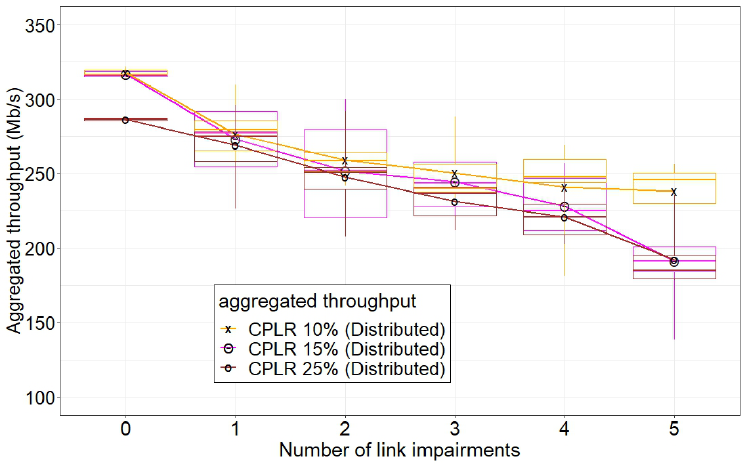
Figure 12. Aggregated throughput behavior of distributed network operation, during data plane link failures for various times under unreliable channel conditions in a 9-node grid network.